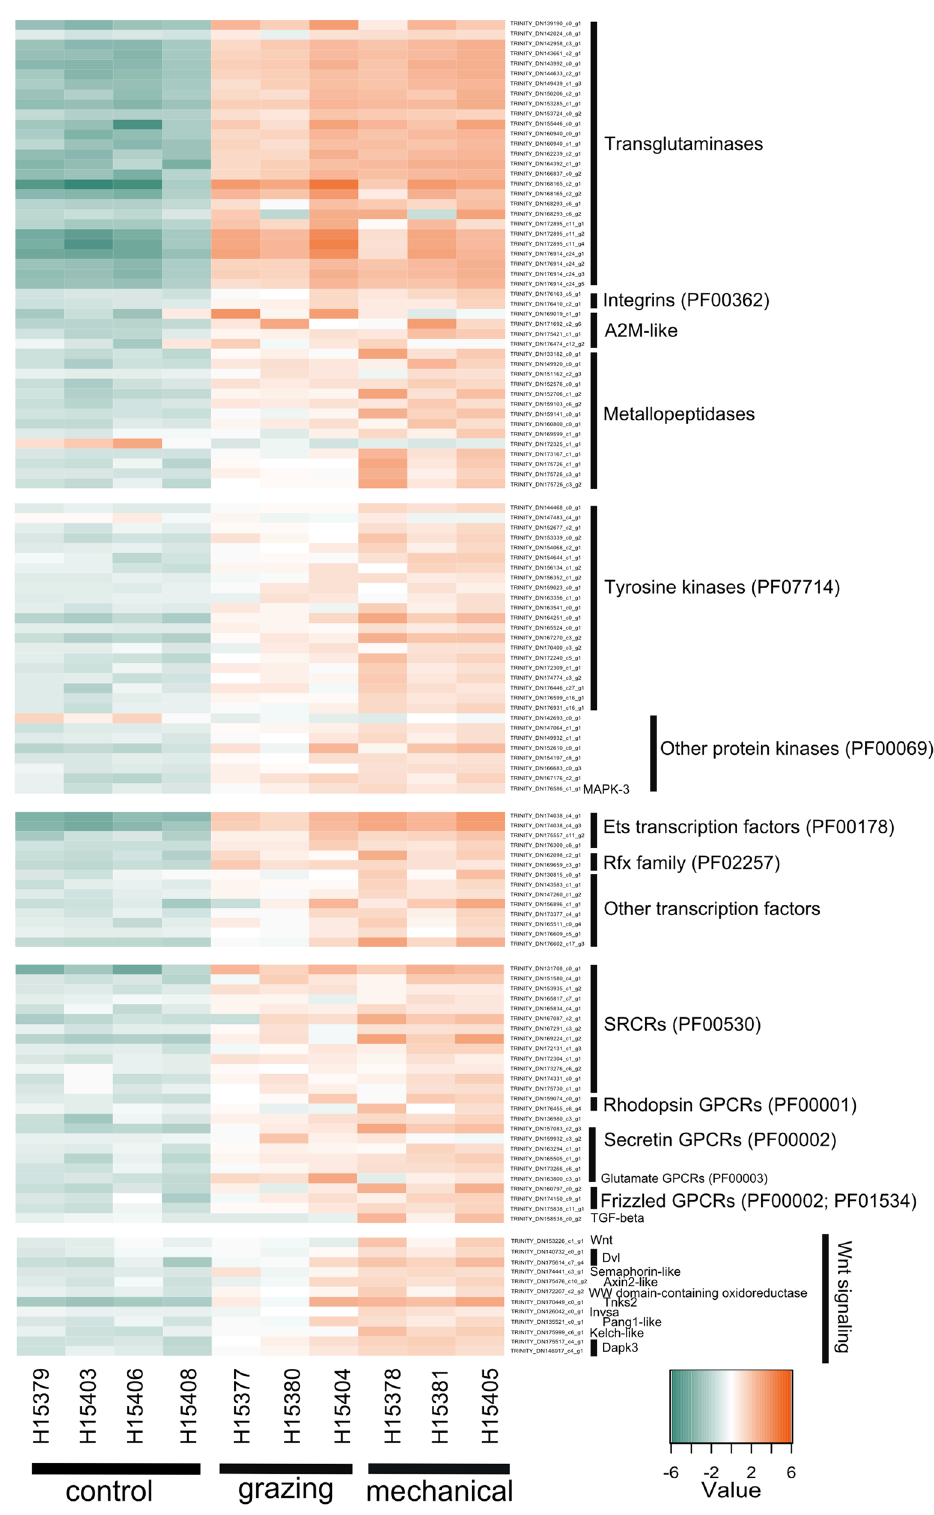
Figure 3. Expression changes of differentially expressed genes involved in clotting-like cascades and signaling during sponge wounding response. Heatmaps showing log 2 -transformed median-centered TMM- normalized expression changes of selected DEG (rows) in each sample from 3 h post-treatment experiment. Differential gene expression analyses were performed in edgeR following Trinity pipeline 45 . Genes were annotated in Trinotate 48 . The domain annotation (PFAM) is shown in brackets. The full list of DEGs is found in Supplementary Data S1